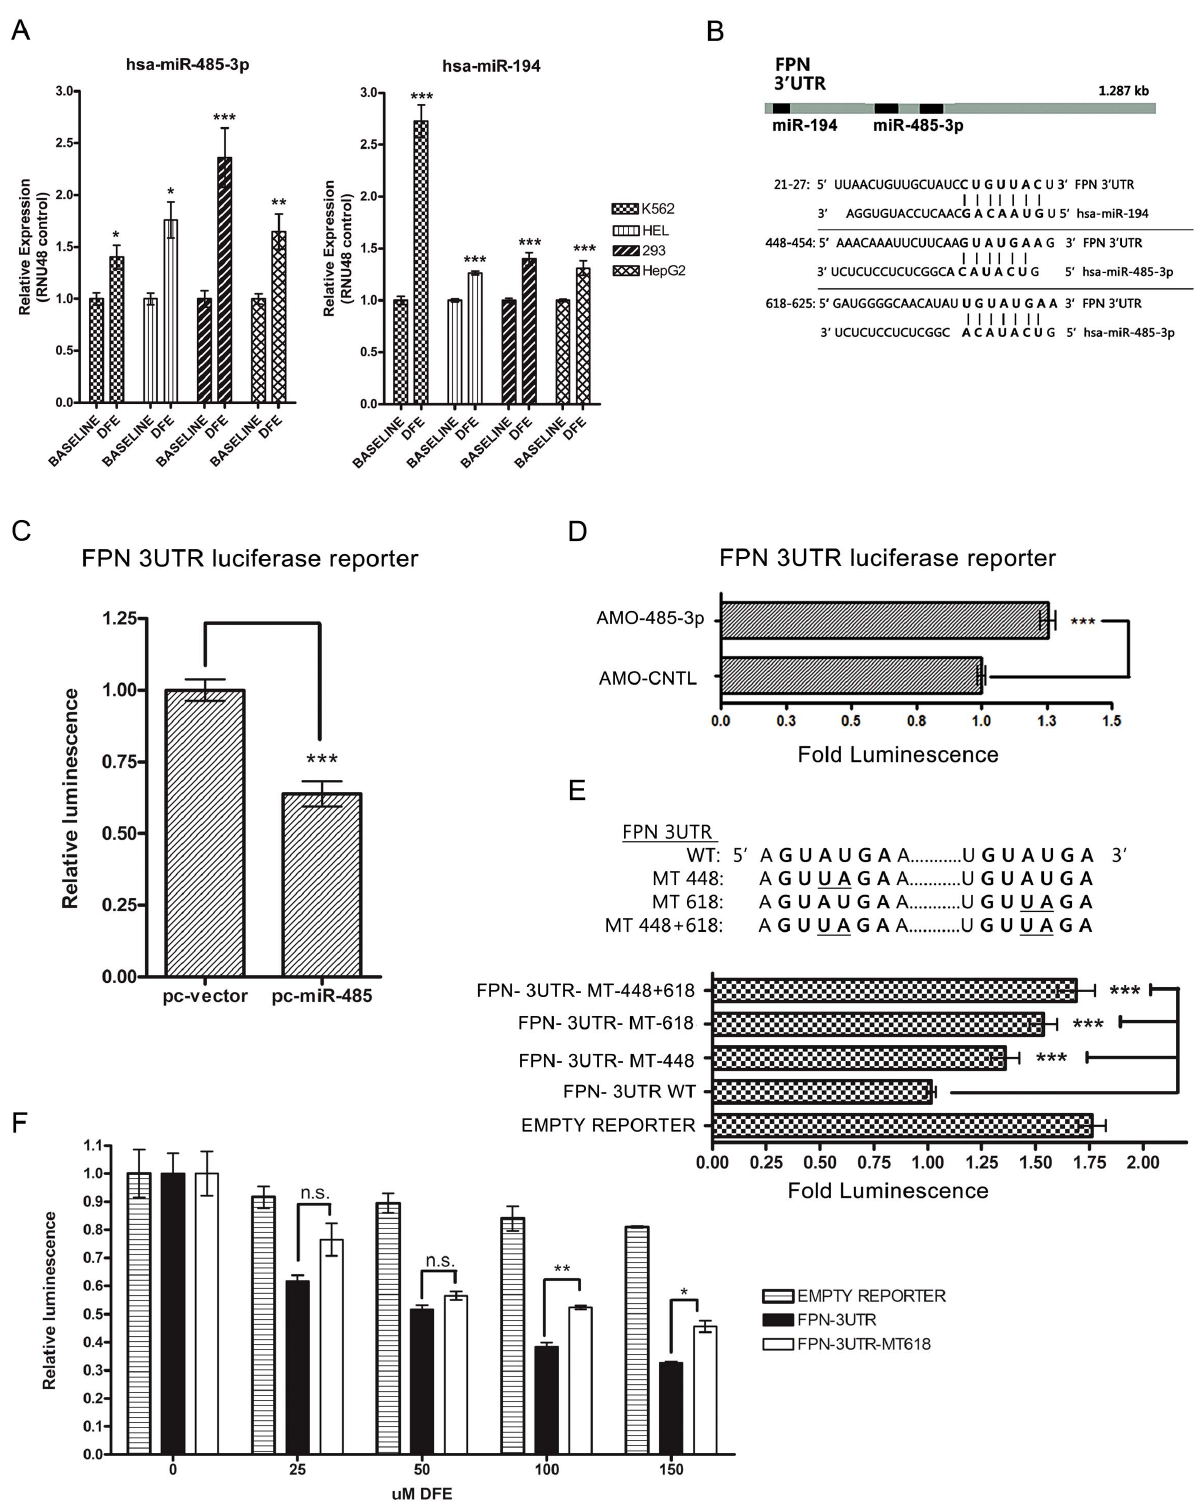
Figure 2. MiR-485-3p directly targets FPN. ( A ) Quantitative real-time PCR (QRT-PCR) analysis of miR-485-3p (left) and miR-194 (right) expression in K562, HEL, HEK-293, and HepG2 cells after treatment with 100 m M DFE, relative to baseline control. Data expressed as fold change in expression relative to RNU48 control (n=4). ( B ) Schematic of the FPN 3 9 UTR with sequence alignments of predicted miR-194 and miR-485-3p target binding sites. ( C ) Fold change in luminescence of FPN 3 9 UTR luciferase reporter in HepG2 cells co-transfected with miR-485 expression construct (pc-miR-485), relative to vector control (pc-vector) (n=3). ( D ) Fold change in luminescence of FPN 3 9 UTR luciferase reporter co-transfected with antisense-mediated oligonucleotides (AMOs) against miR-485-3p (AMO-485-3p), expressed as fold change 6 SEM relative to non-targeting control AMO (AMO-CNTL (n=4). ( E ) Fold change in luminescence of mutant MT-448 + 618 FPN 3 9 UTR, MT-618 FPN 3 9 UTR, MT-448 FPN 3 9 UTR, WT 3 9 UTR and empty luciferase